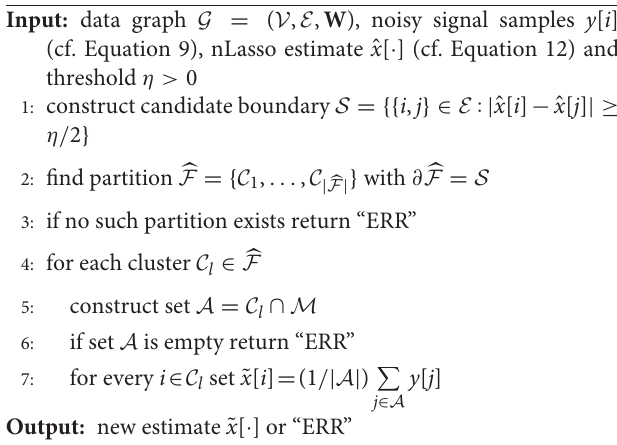
Algorithm 1 Post-Processing for